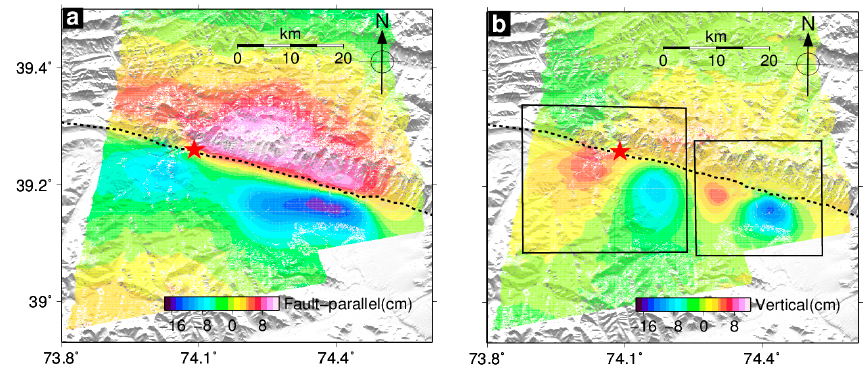
Figure 3. Deformation maps decomposed from T027A and T107D SAR measurements. ( a ) Fault-parallel deformation; ( b ) vertical deformation. The regions outlined by the black rectangular box represent the areas with similar coseismic deformation patterns.